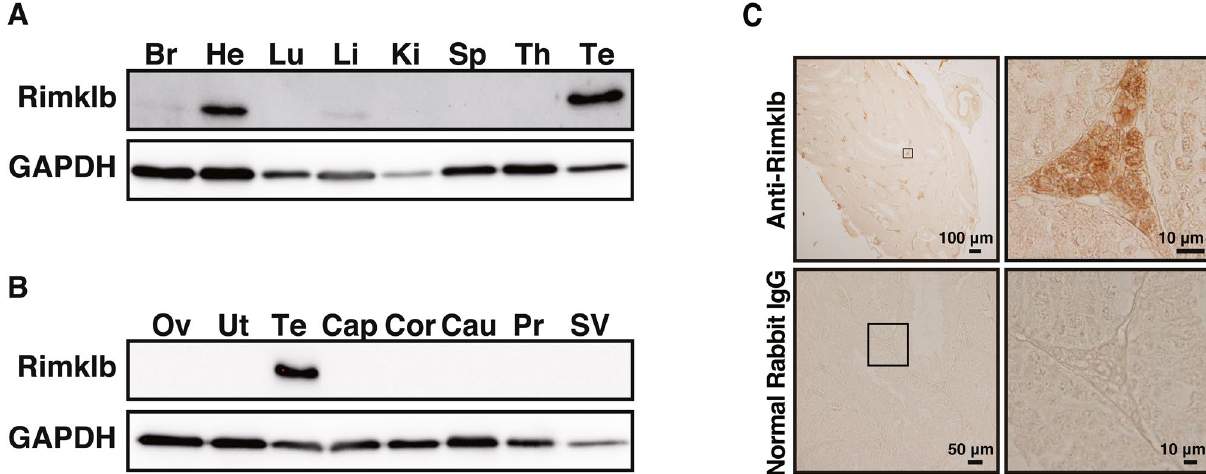
Figure 1. Expression profile of Rimklb in mouse tissues. ( A ) Western blot analysis of Rimklb. Br brain, He heart, Lu lung, Li liver, Ki kidney, Sp spleen, Th thymus, Te testis, ( B ) Western blot analysis of Rimklb in reproductive organs. Ov ovary, Ut uterus, Cap caput epididymidis, Cor corpus epididymidis, Cau cauda epididymidis, Pr prostate gland, SV seminal vesicle. GAPDH was used as a loading control. ( C ) Rimklb expression in mouse testis sections as determined by immunostaining, using normal rabbit IgG as a negative control. Enlarged images of the boxed area are shown (Right). Note that Rimklb is mainly expressed in the Leydig cells of the